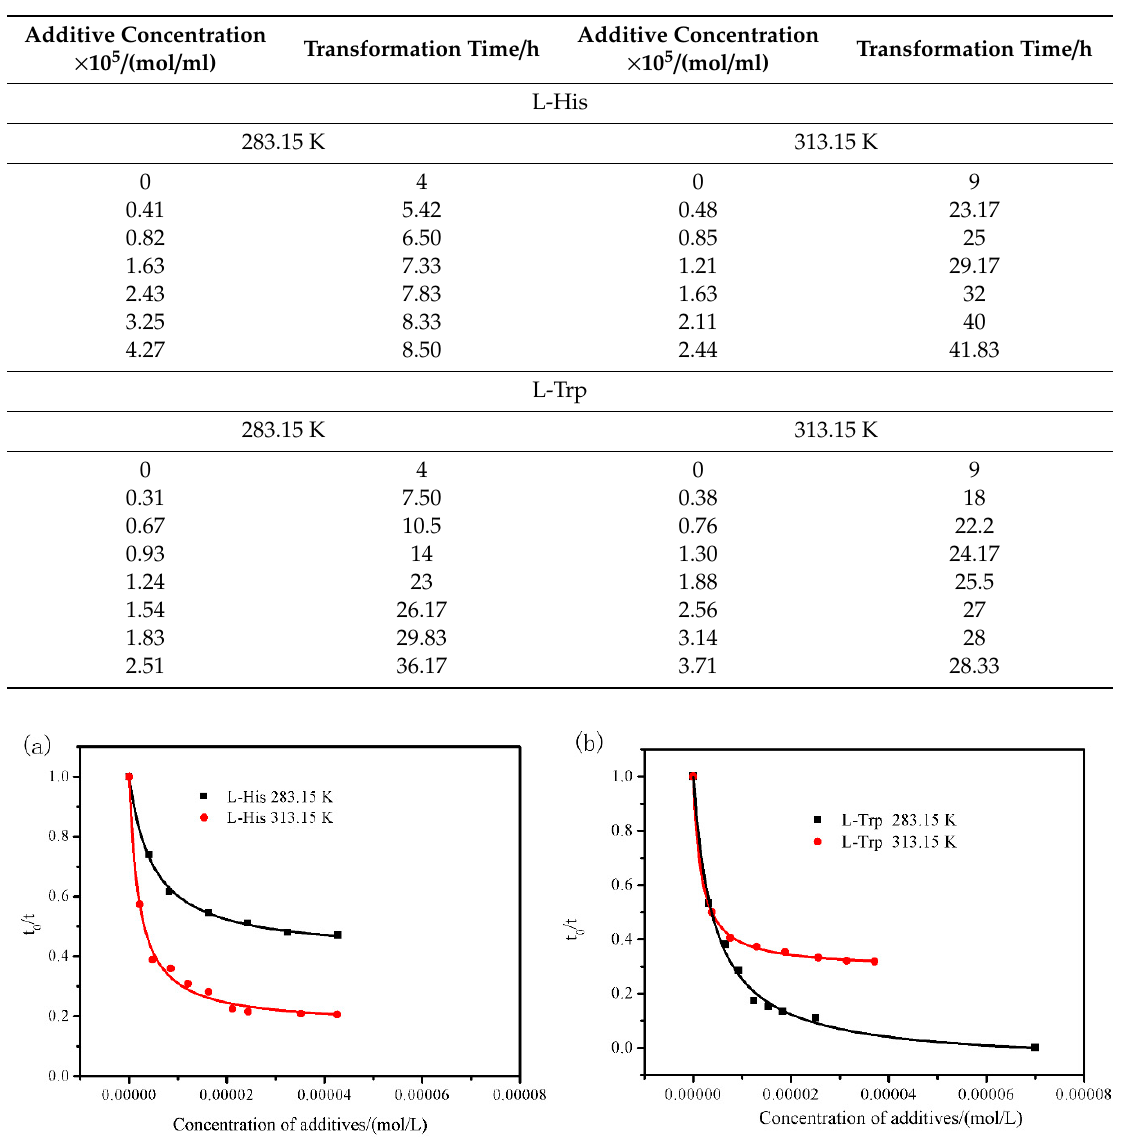
Table 4. E ff ect of additive concentration on the transformation behavior of L-Phenylalanine.